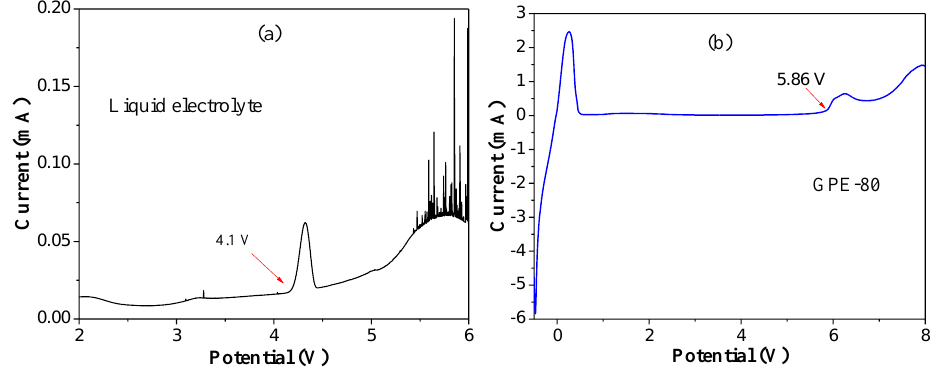
Figure 5. Electrochemical window test results of liquid electrolyte ( a ) and GPE-80 ( b ).